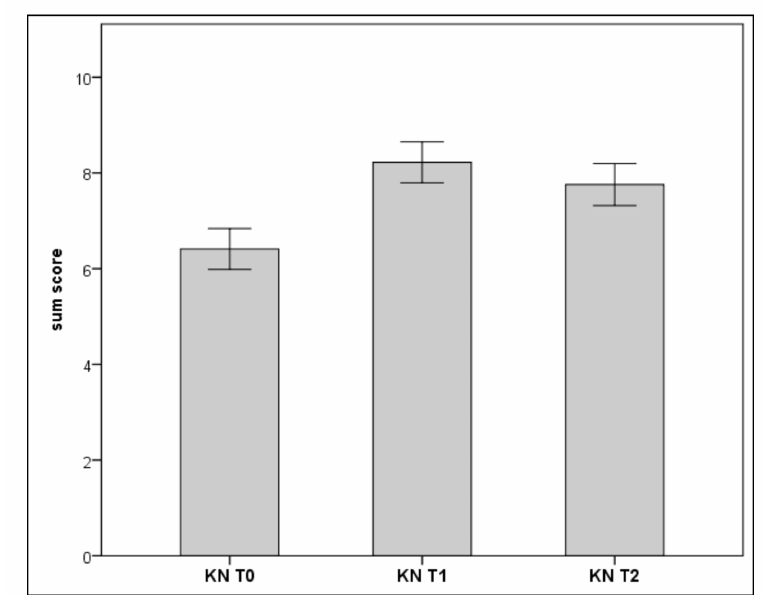
Figure 1. The knowledge sum scores at all three test times; N = 136; error bars show 95%